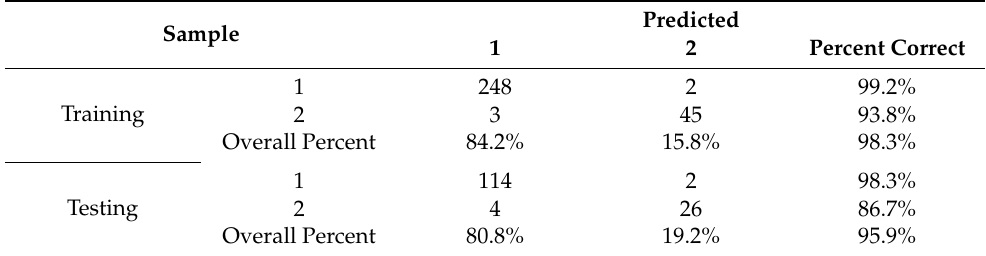
Table 11. Classification ability of NN.